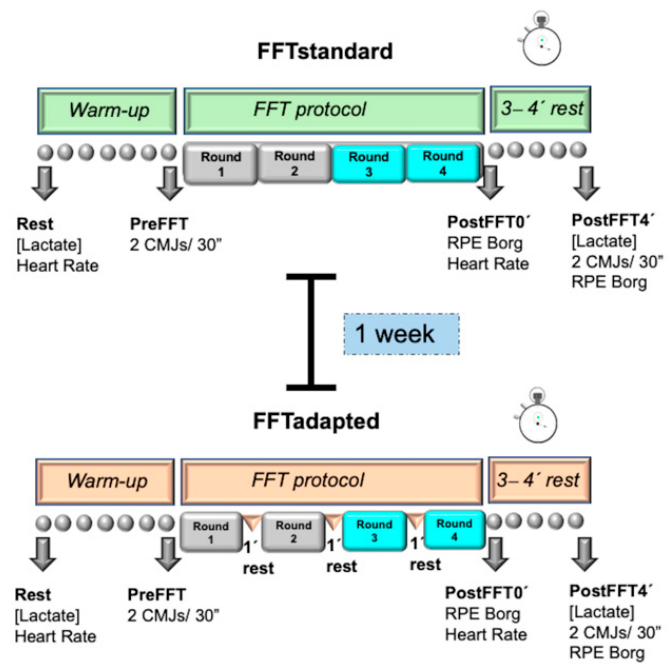
Figure 2. FFTstandard and FFTadapted.